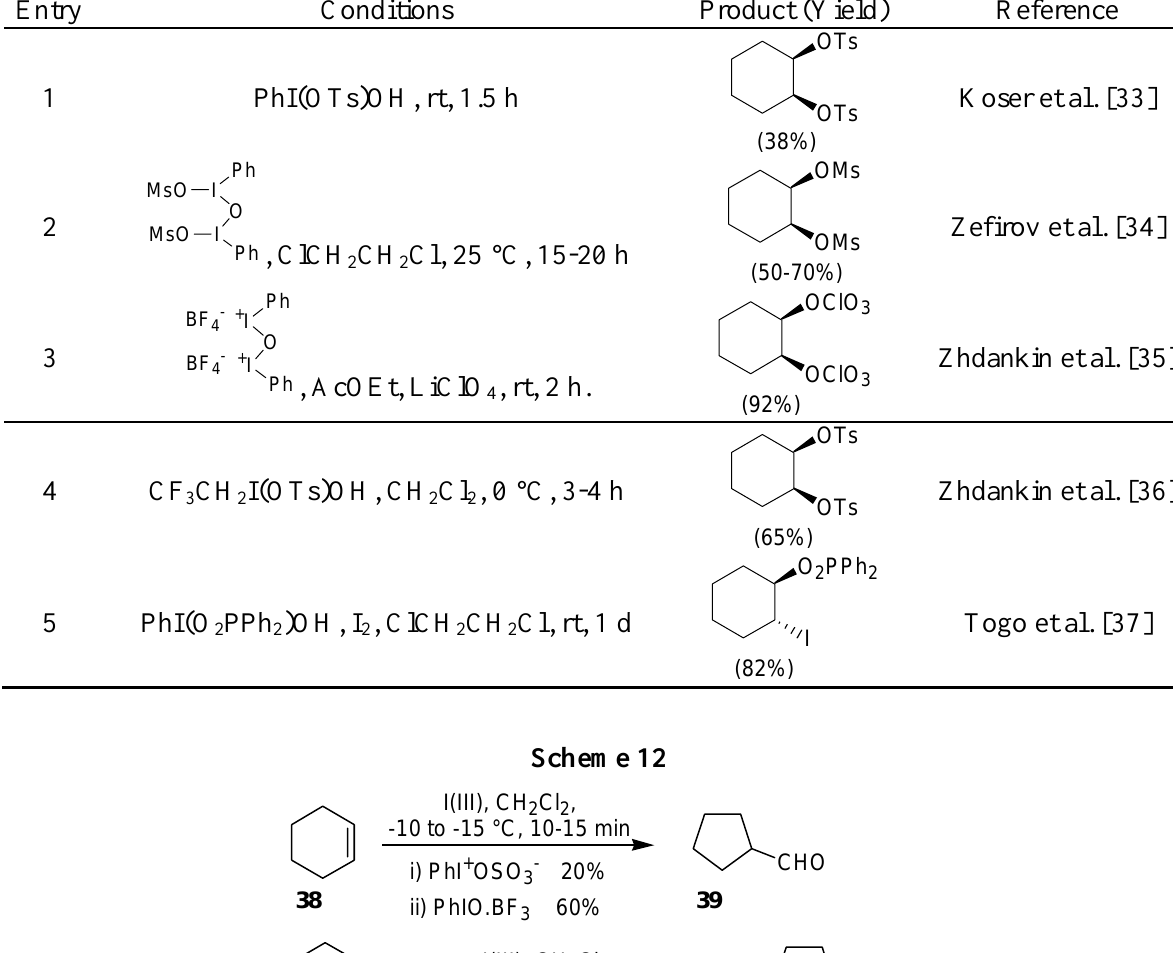
Table 3 . Representative examples of I(III)-promoted addition reactions of cyclohexene. Entry Conditions Product (Yield)